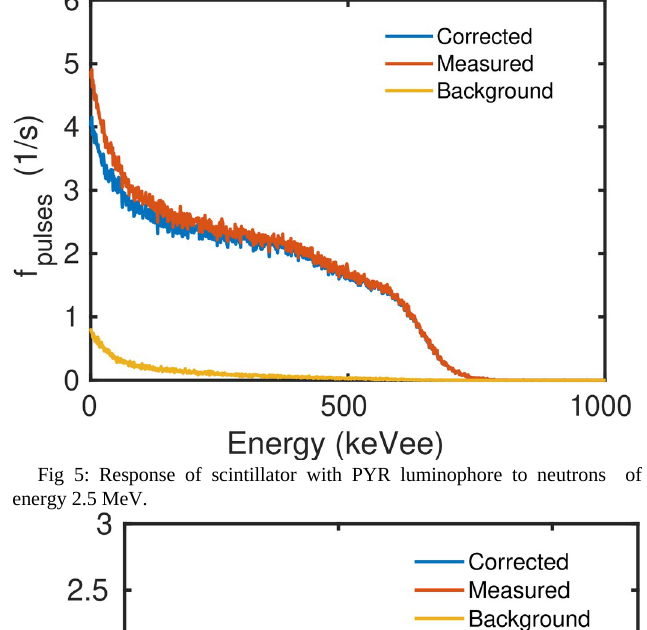
Fig 8: Deposited energy of scintillator with only DIPN and DIPN with luminophore to neutrons of energy 2.5 MeV.